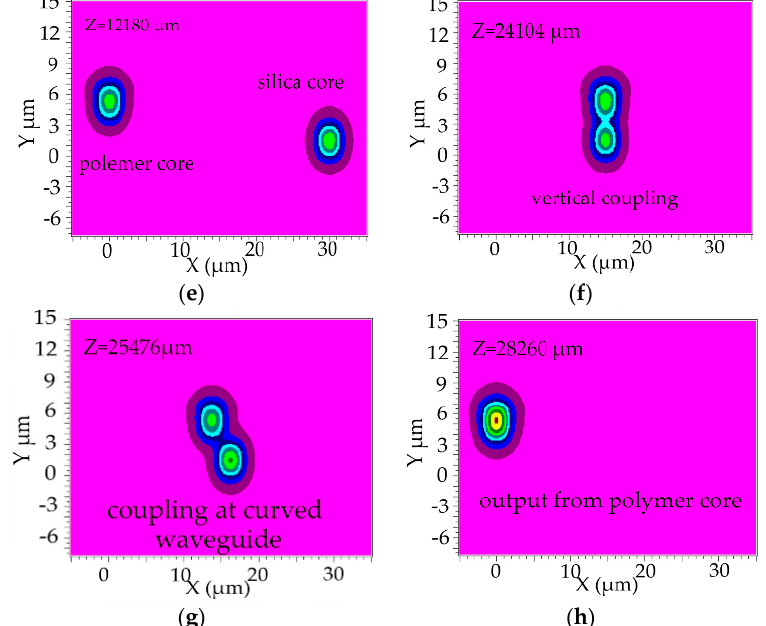
Figure 4. ( a ) The 3D geometric model of the inverted ridge TO switch; ( b – h ) corresponding to the light transmission in x–y direction at z axis positions of 440 μ m, 2784 μ m, 3676 μ m, 12,180 μ m, 24,104 μ m, 25,476 μ m, 28,260 μ m, respectively ( a = 3 μ m, h = 1.22 μ m; L c = 2.049 mm; m = 6 μ m, L = 1 cm, n c 1 = 1.48, n c 2 = 1.478 and n 1 = 1.444).